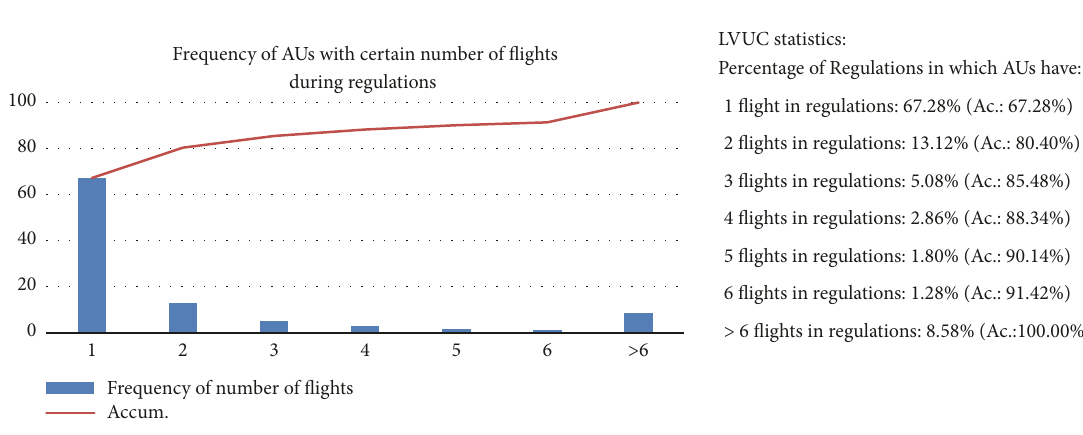
( hotspots ), it typically does not lead to an optimal allocation of the ATFCM slots in terms of costs for the AUs [14, 15]. Due to the level of saturation in both the European and US airspaces, a massive number of flights receive ATFCM delays every day, the Airspace Users (AUs), the airports, and passengers [4,